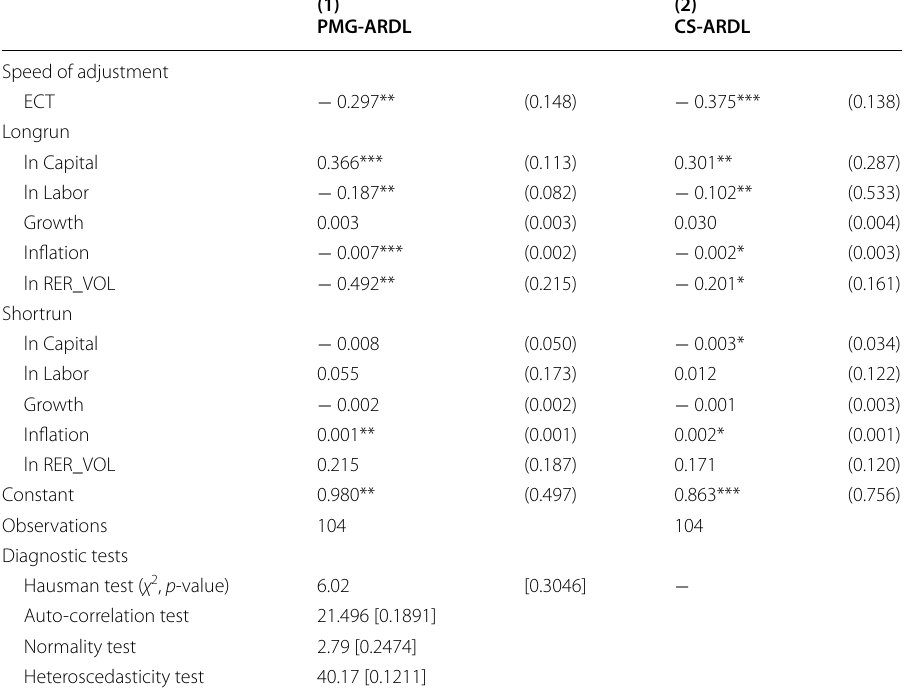
Table 9 Real exchange volatility and the services sector performance. Source: Authors’